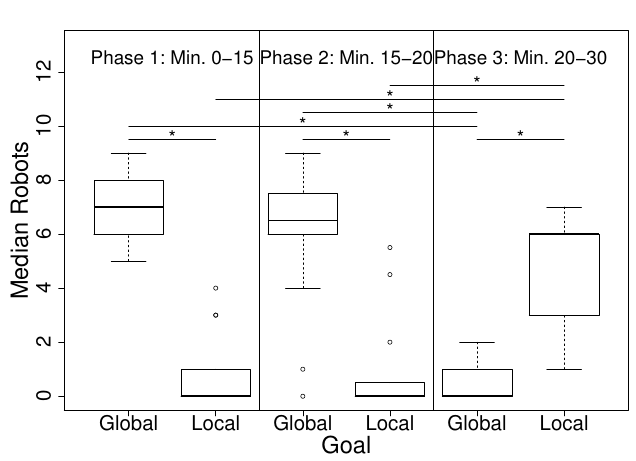
Figure 6: Median number of robots in the respective area over time per phase. Results are significantly different, except in the case of global optimum of phase 1 with global optimum of phase 2, and also local optimum of phase 1 with local optimum of phase 2.